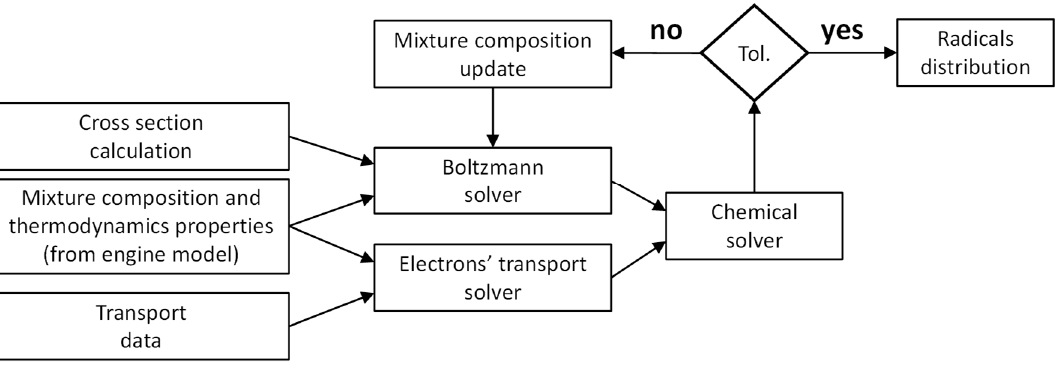
Figure 3. Process flow diagram of the Corona-discharge model.